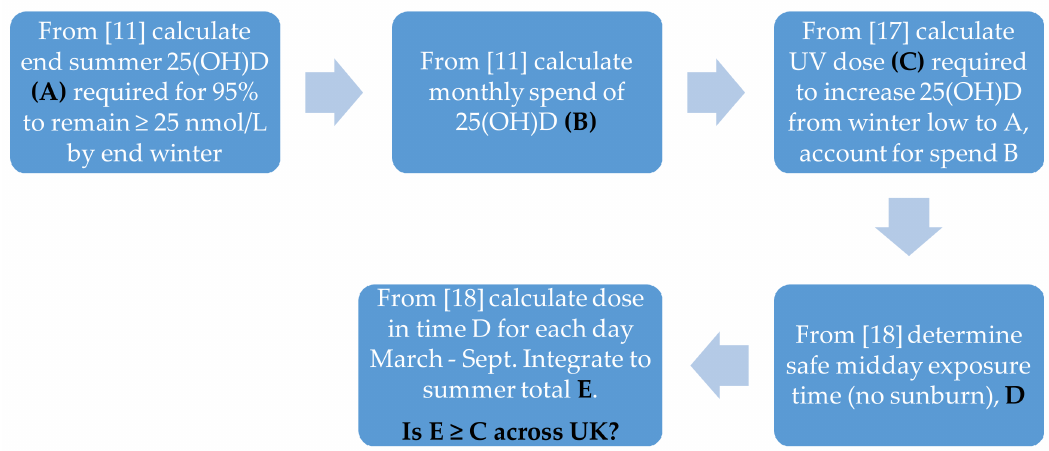
Figure 1. The sequence of analyses that led to the final sunlight exposure calculations for white Caucasians (skin types I–IV). Calculations do not consider any explicit dietary intake of vitamin D, but are based on results from volunteers who did acquire some oral vitamin D. The median was 3.26 (10–90 percentile, 0.91–7.81) µ g/day (130.4 IU/day) [11]. Therefore, these small intakes are implicit in the end